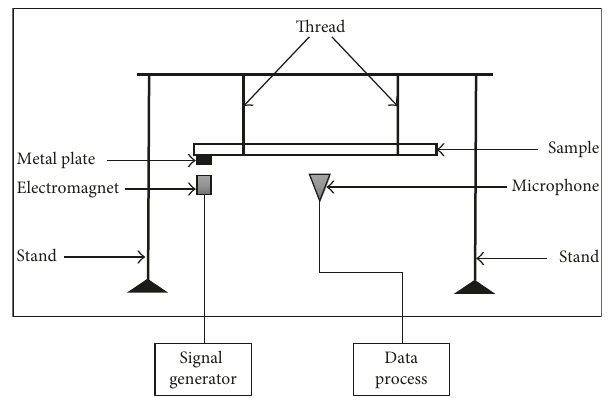
Figure 1: Schematic diagram for free-free flexural testing [11].